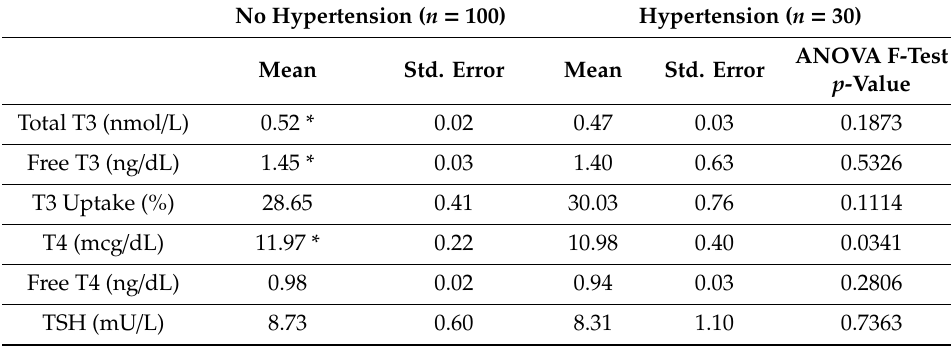
Table 6. E ff ect of hypertension on fetal thyroid hormones.